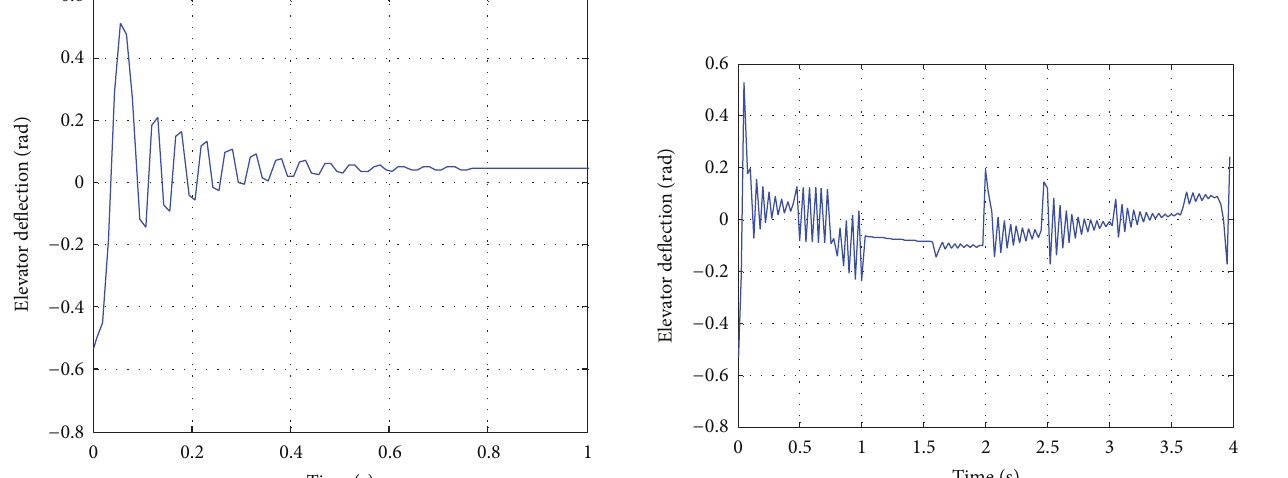
Figure 13: The response of angle of attack.